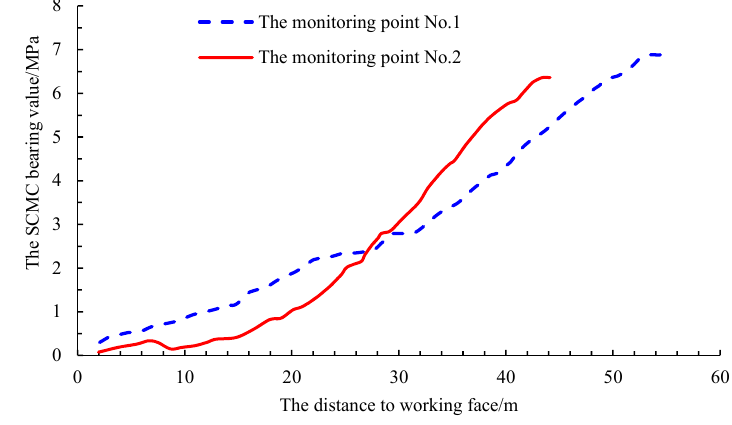
Figure 15. The bearing stress of SCMC in the goaf.